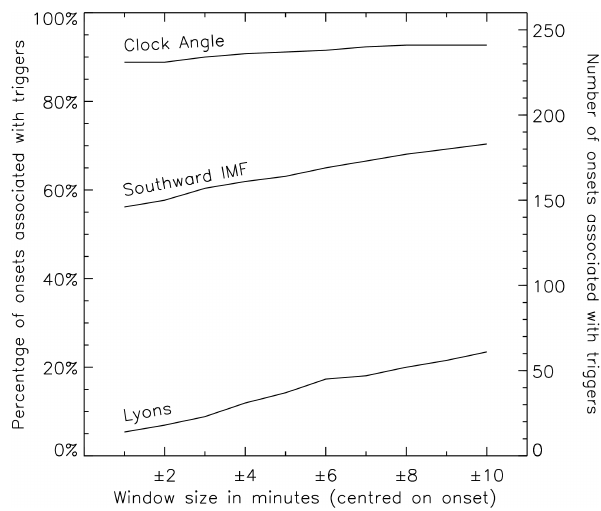
Fig. 5. Variations in the number of substorms associated with IMF triggers as a function of association window length. The number of substorms with at least one trigger within the indicated window length is presented for both northward IMF triggers (according to Lyons criteria 1–4), southward IMF triggers (Lyons criterion 1 only) and the IMF clock angle criterion introduced in the text (more than 22min of IMF clock angle magnitude greater than 45 ◦ in the pre- ceding